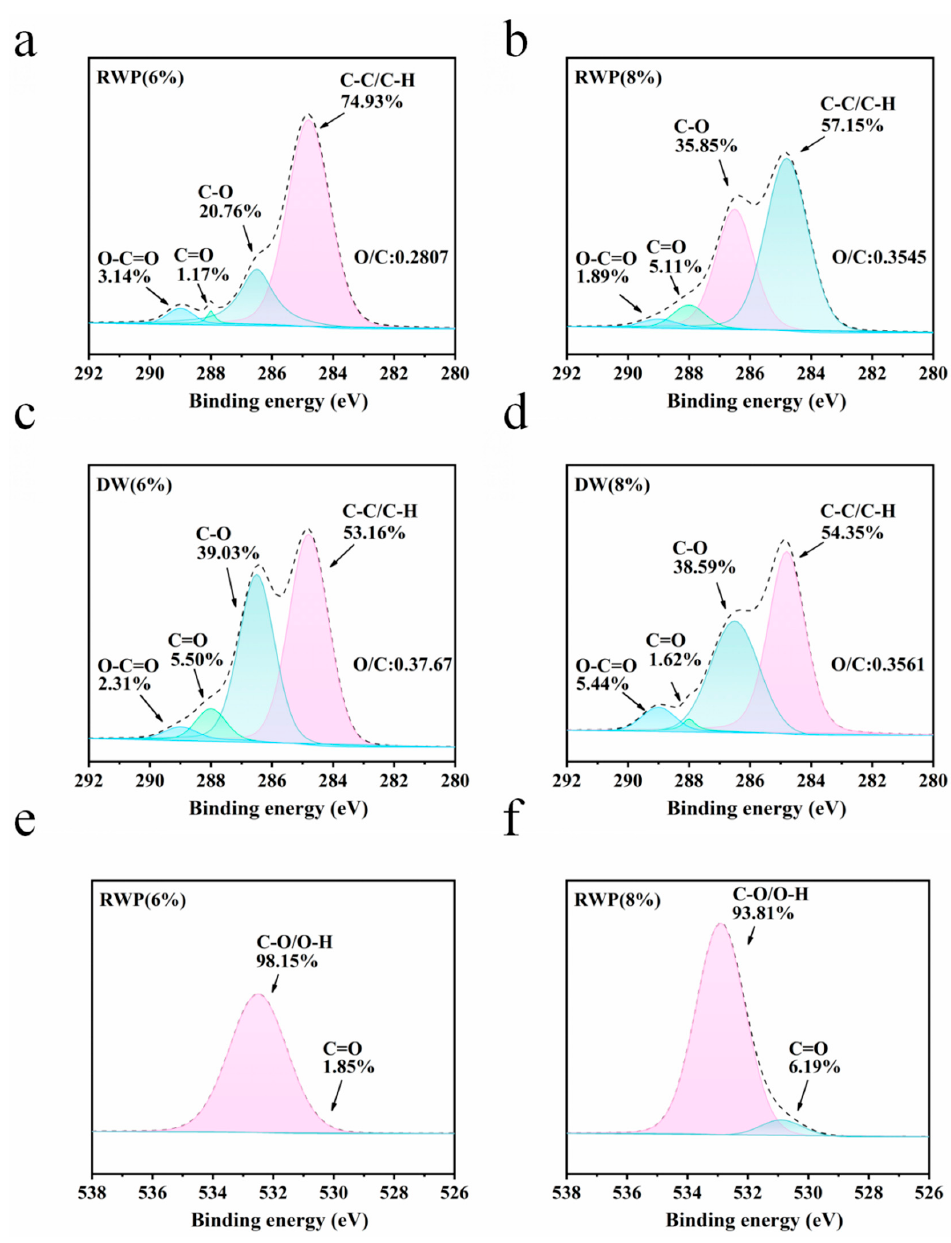
Figure 5. ( a – d ) XPS carbon fractionation results analysis; ( e , f ) XPS oxygen fractionation results anal- ysis.